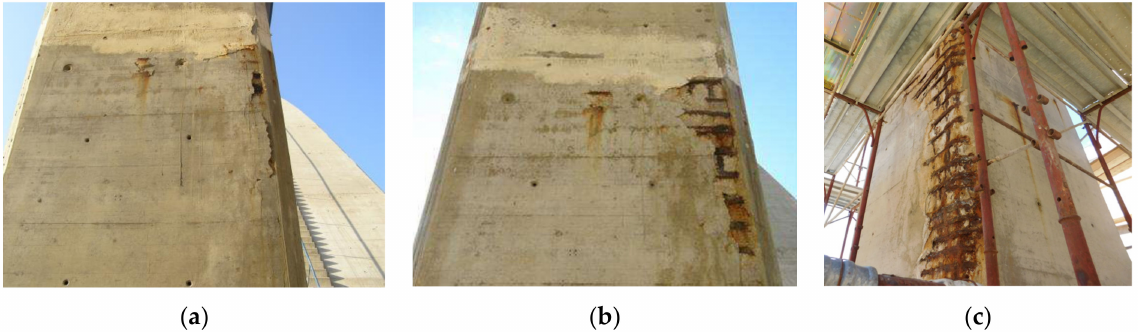
Figure 4. Propagation of corrosion of the reinforcement on the pier P3 in different periods: ( a ) 2006, ( b ) 2010; ( c ) 2017—shortly before